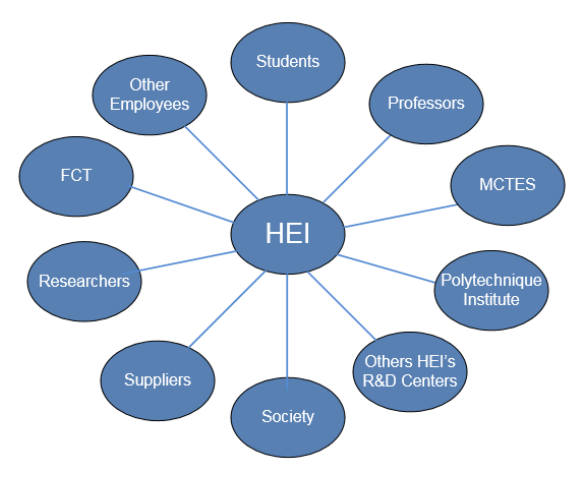
Figure 2: Stakeholders diversity regarding the HEI studied